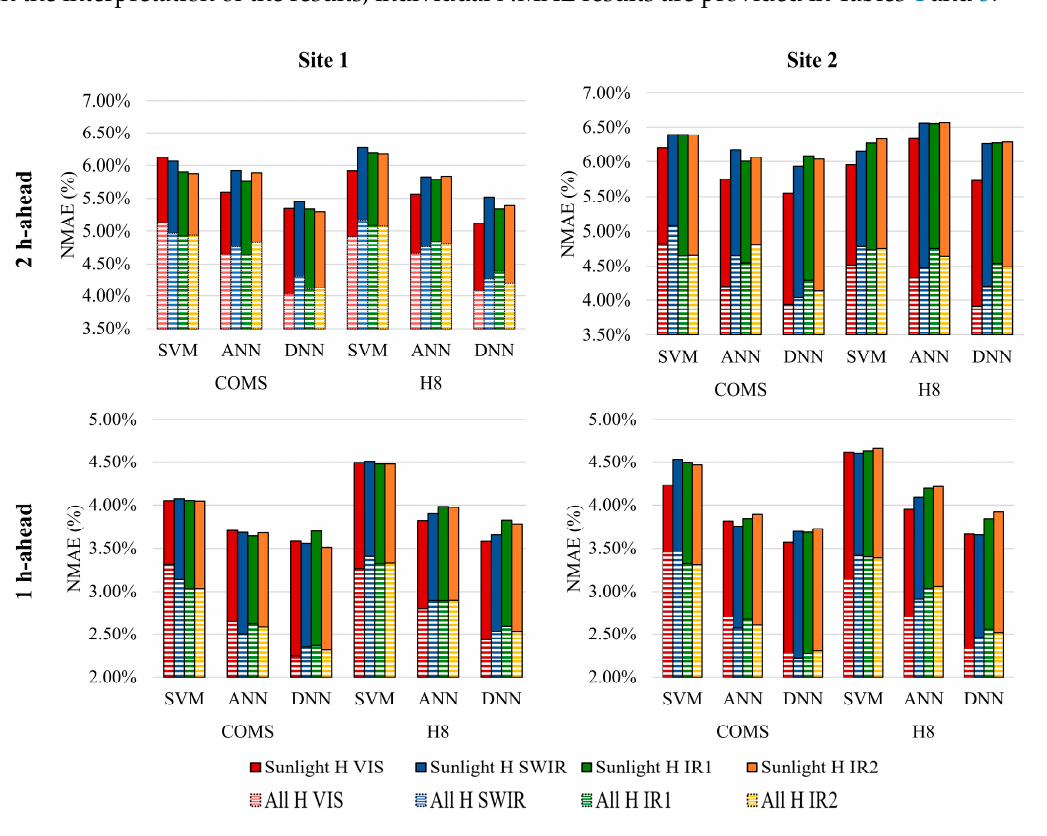
Figure 9. 2 hour (h)- and 1 h-ahead PV forecast results in normalized mean absolute error (NMAE) (%) for each spectral band from COMS and H8 datasets using support vector machine (SVM), artificial neural network (ANN), and DNN models. Solid color bars represent the “Sunlight H” time frame, whereas the overlapping stripe color bars represent the “All H” time frame using identical NMAE scales. Table 4. NMAE results from 2 h-ahead PV power forecast for COMS and H8 datasets using three forecast models in “Sunlight H” and “All H” time frames (bold text indicates the lowest NMAE for each forecast model).